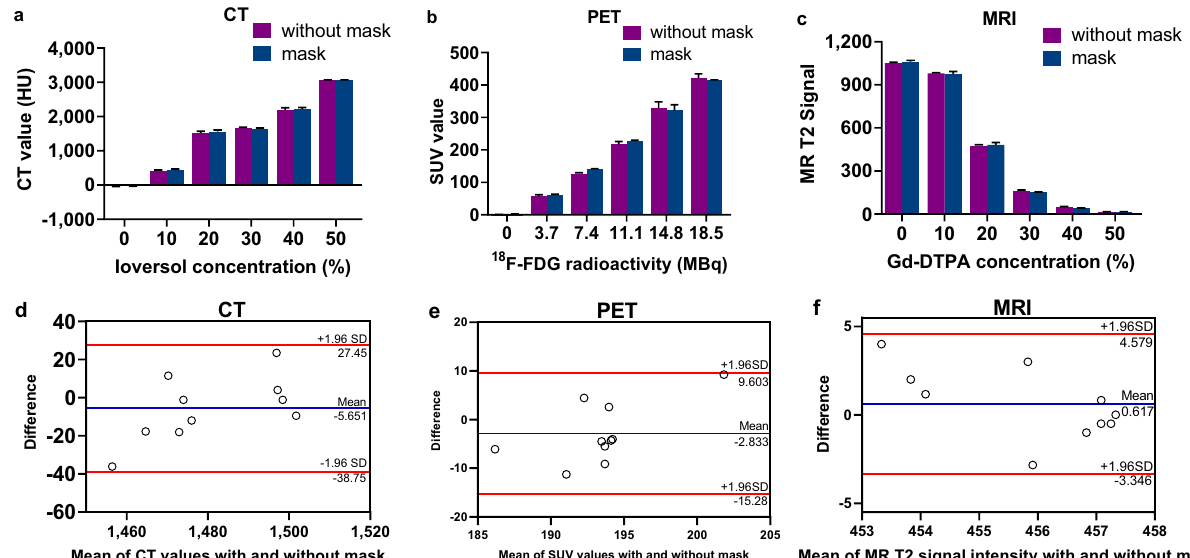
Figure 5. Phantom CT, MRI and PET studies with and without the thermoplastic mask. (a–c) : The CT, SUV and MR signal values acquired with different concentrations of ioversol, different radioactivity values or different concentrations of the Gd-DTPA agent. (d–f) : Bland–Altman plot of the CT, SUV or MR signal values from the phantom measurements from the images with and without the mask. The solid blue line indicates the mean difference; the upper and lower red lines indicate ± 1.96 × standard